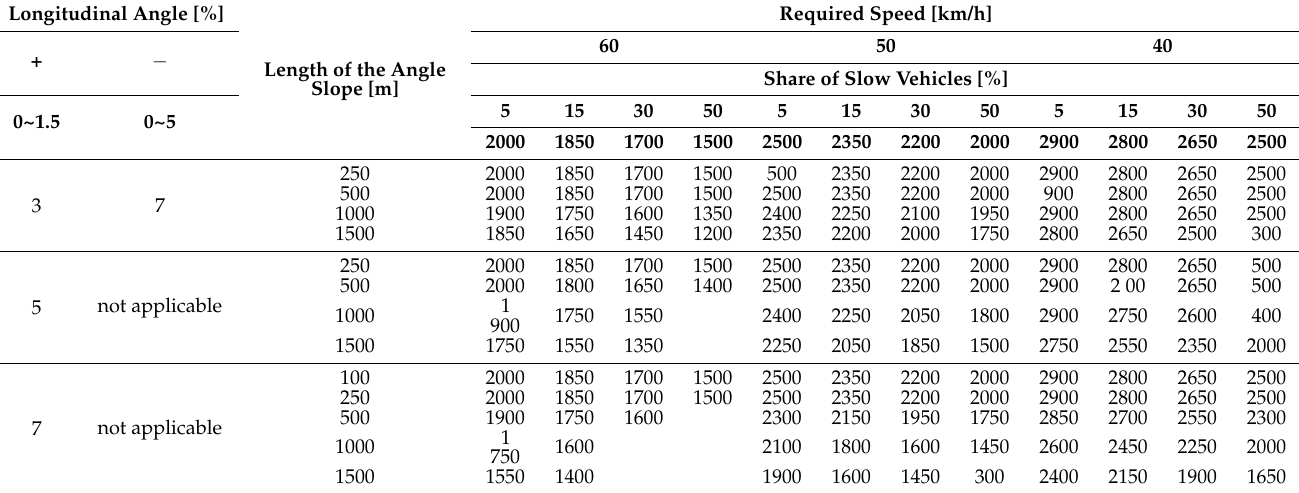
Table 2. Basic values of permissible traffic flow intensities I z on four-lane urban road [vehicle/h] [65]. Longitudinal Angle